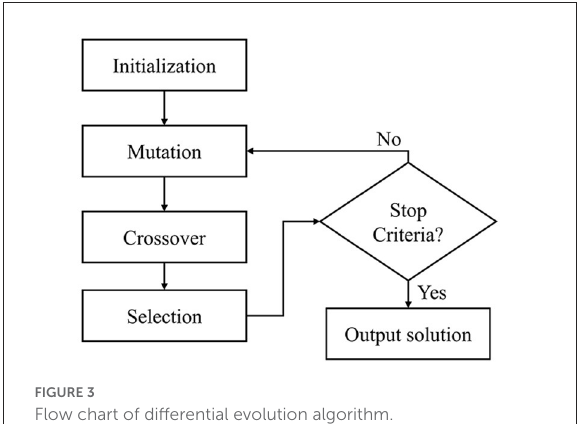
FIGURE3 Flow chart of differential evolution